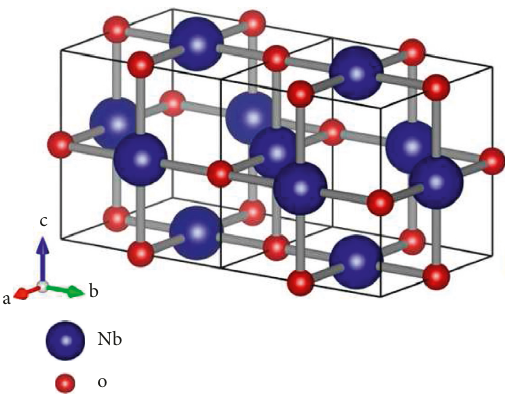
Figure 1: Cubic structure of